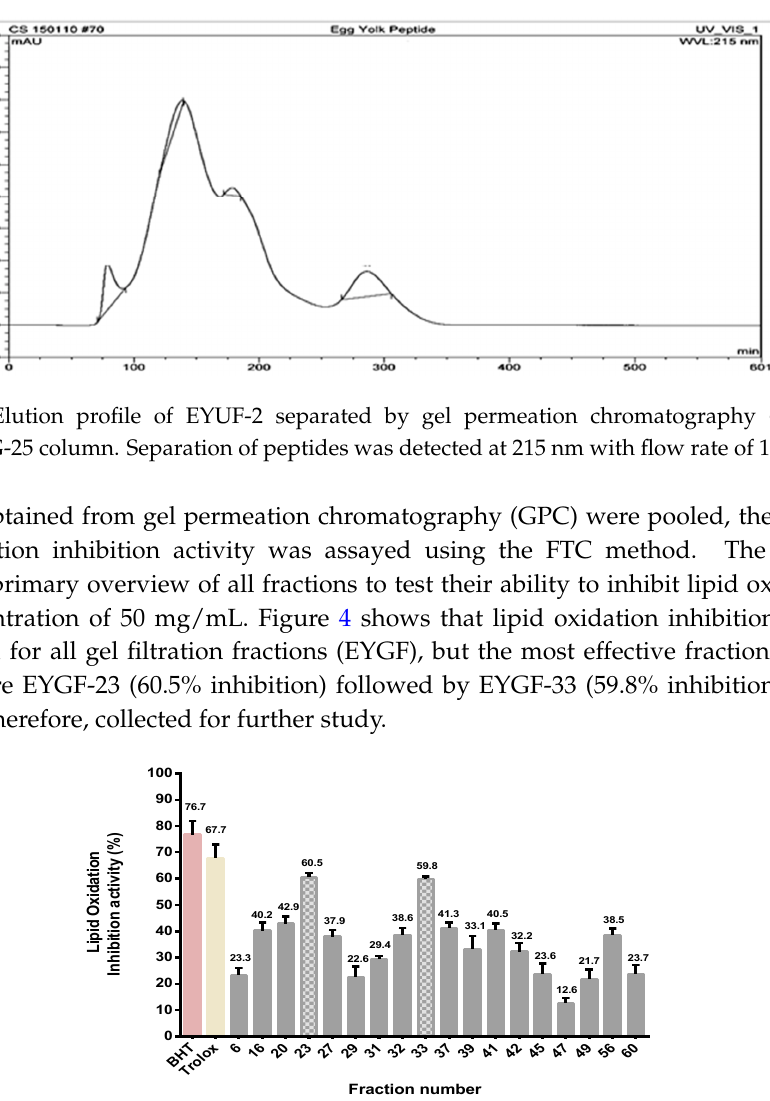
Figure 4. Lipid oxidation inhibition activity (%) is shown at the top of the bars for gel filtration fractions using the ferric thiocyanate (FTC) method. The activity was analyzed for 50 mg/mL of all fractions separated on a Sephadex G-25 column. The absorbance was measured after 4 days incubation at a wavelength of 500 nm. Data correspond to the means ± SD of three independent experiments. The results were compared with positive controls (0.2 mg/mL) trolox and (0.2 mg/mL) BHT, shown in colour. The two shaded bars (fractions 23 and 33) showed the highest activities and were selected for further study.